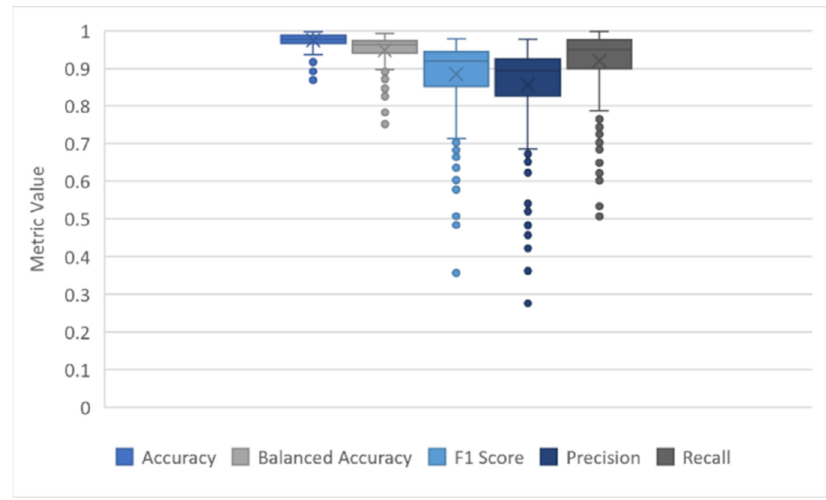
Figure 3. Metrics for CanVec baseline data. Table 3. Evaluation metrics for waterbody segmentation methods. Standard deviations presented in brackets. Optimal values for each metric presented in